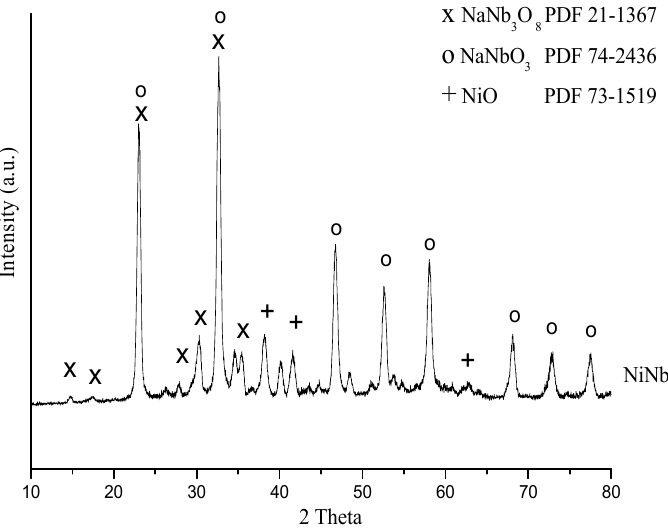
Figure 1. Results of X-ray diffraction (XRD) analysis of the NiNb catalyst.